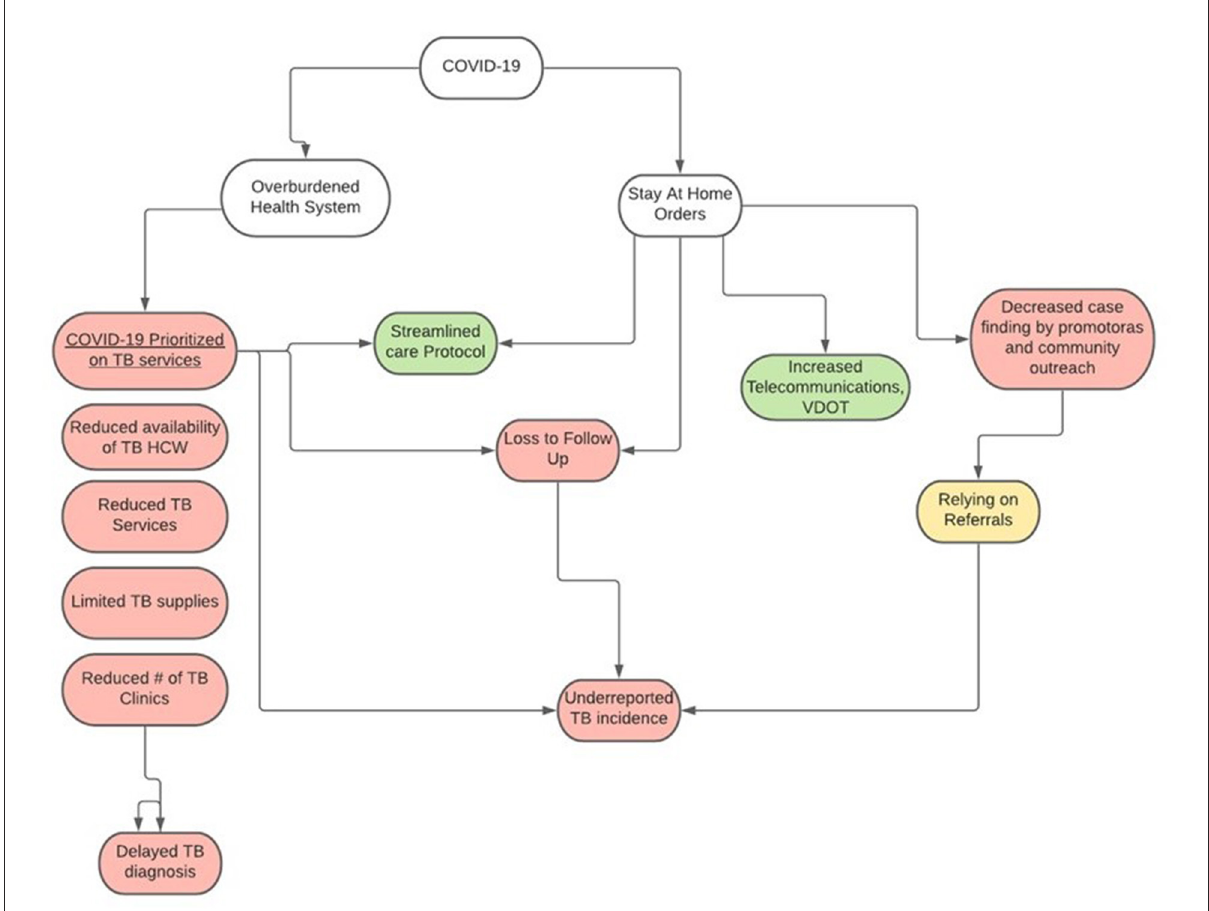
FIGURE6 Impacts of COVID-19 pandemic on tuberculosis (TB) case detection and service delivery in Baja California, México 2021. Pink, Negative impact; Green, Positive